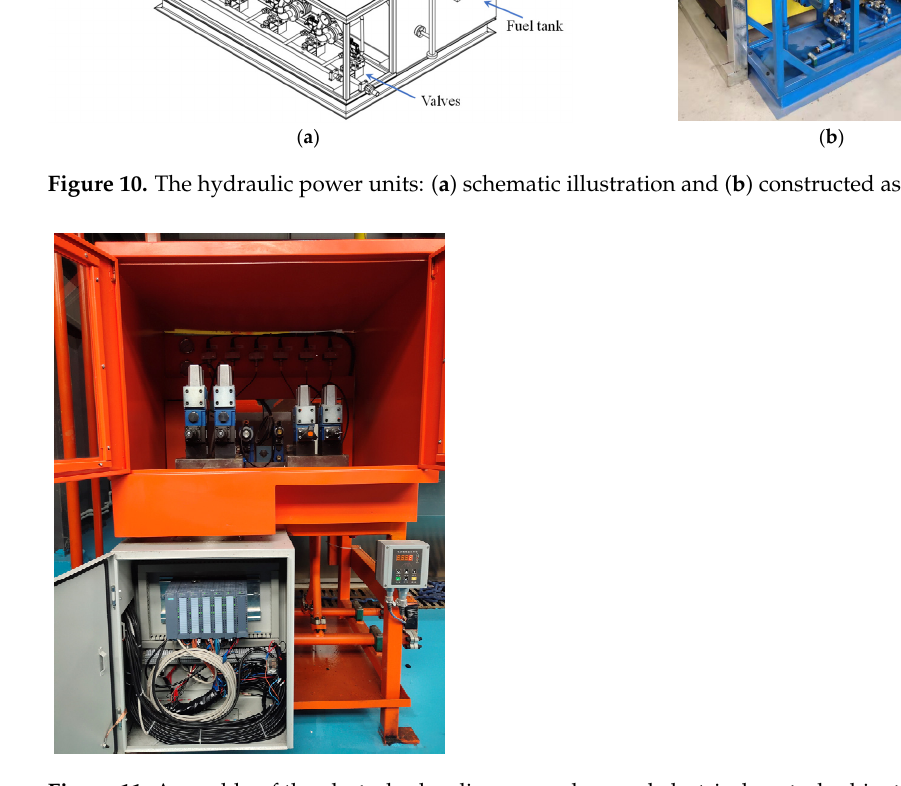
Figure 11. Assembly of the electrohydraulic servo valves and electrical control cabinet.